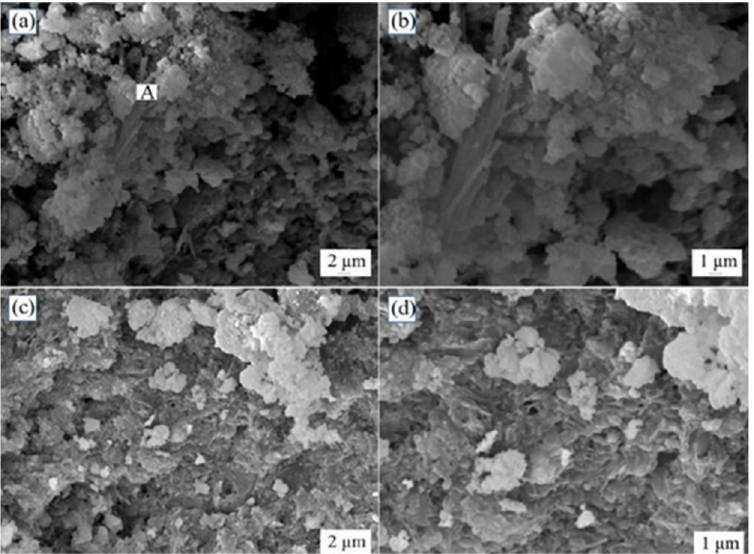
Figure 5. SEM microstructures of copper slag cementitious material after curing and hydration for ( a , b ) 7 days and ( c , d ) 28 days [30].